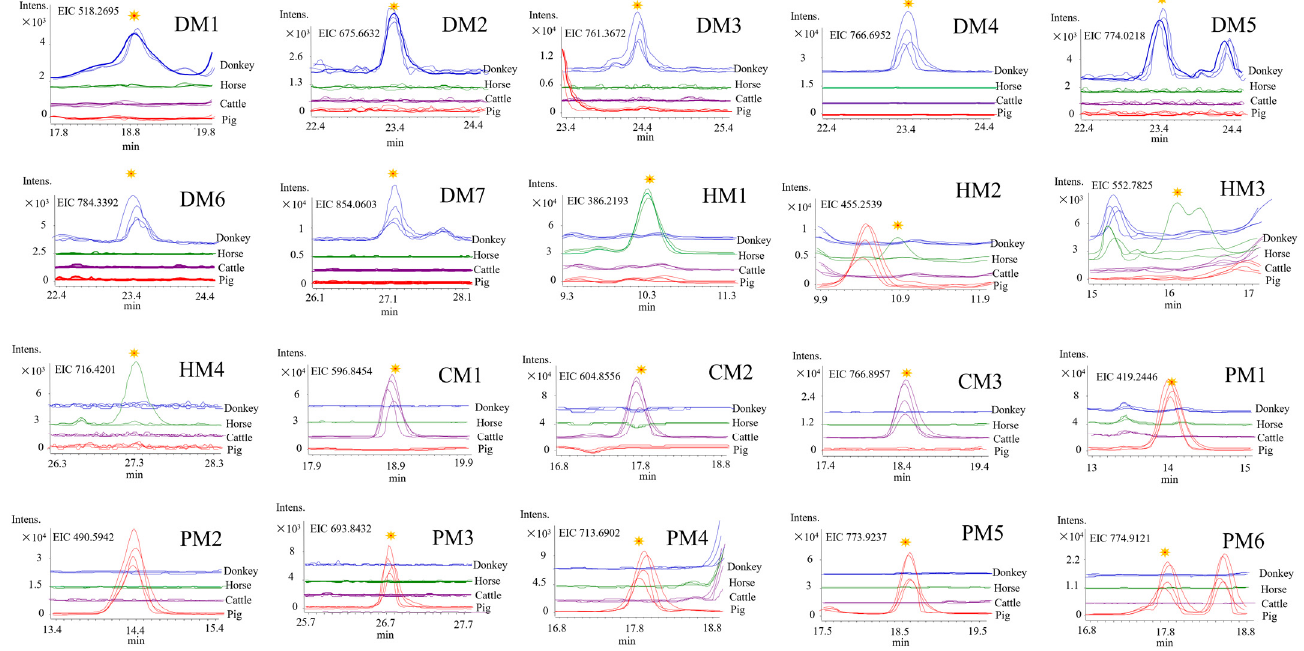
Figure 3. Extracted ion chromatograms of specific marker ions for four animal gelatins. The mass accuracy is 0.1 Da. Table 1. The specific marker ions found in the peptide fragments produced from trypsin digestion of different animal skin gelatins by LC-Q-TOF-MS analysis.